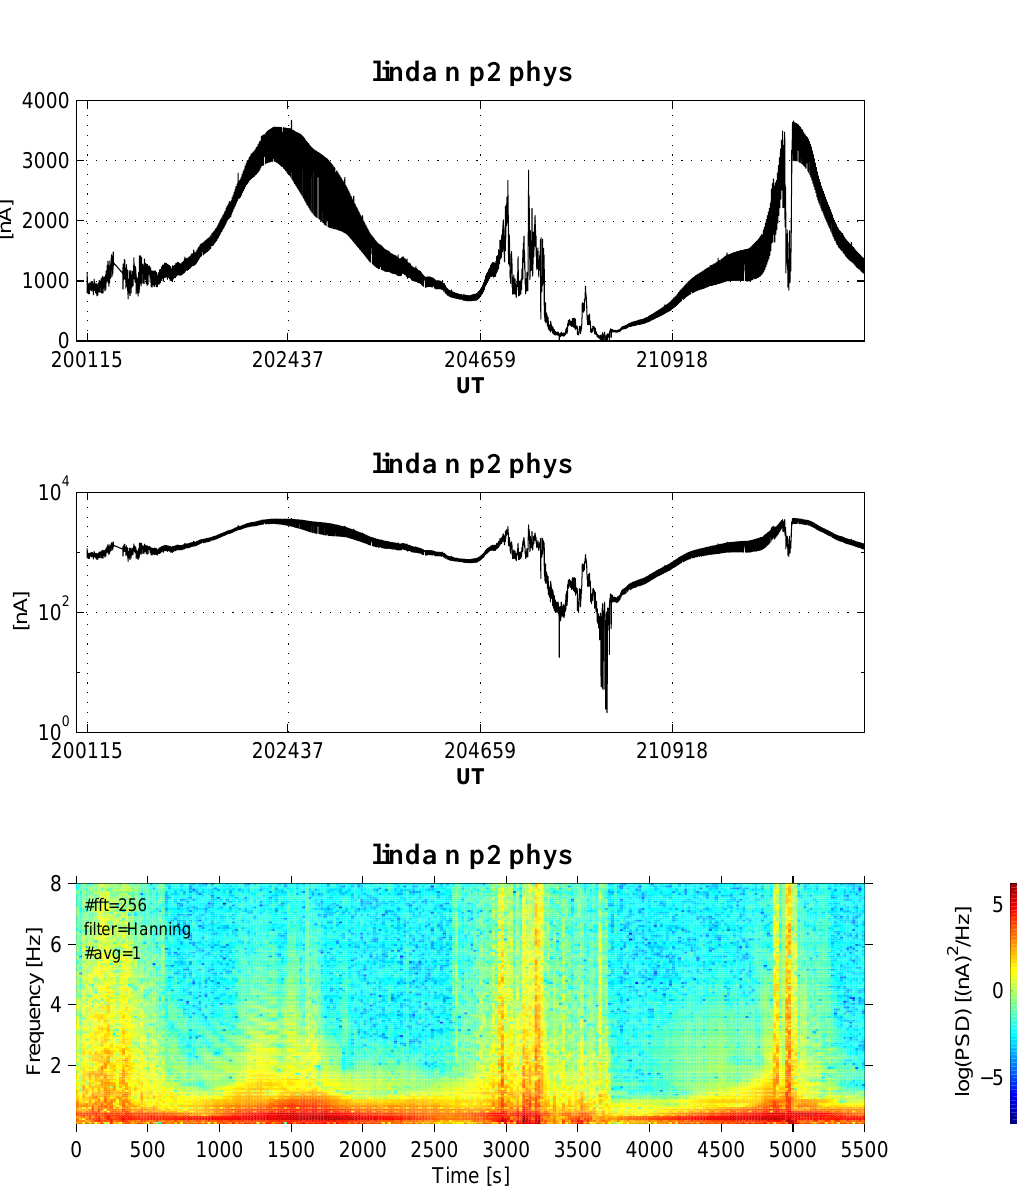
Fig. 1. One orbit overview of LINDA probe current data. The upper two panels show the same time series of the probe current with two different scalings, linear and logaritmic, respectively, emphasizing different parts of the information. The lower panel show a spectrogram of the same data. The data collection starts in the northern summer auroral regions (until 20:10 UT), continuing through the daytime equatorial region (until 20:40 UT) into a very structured southern winter polar region, and ends in the evening equatorial region. The spectrogram in the lower panel shows a nice example of a set of MHD pulsations with density perturbations in the dayside ionosphere between 20:07 UT to 20:35